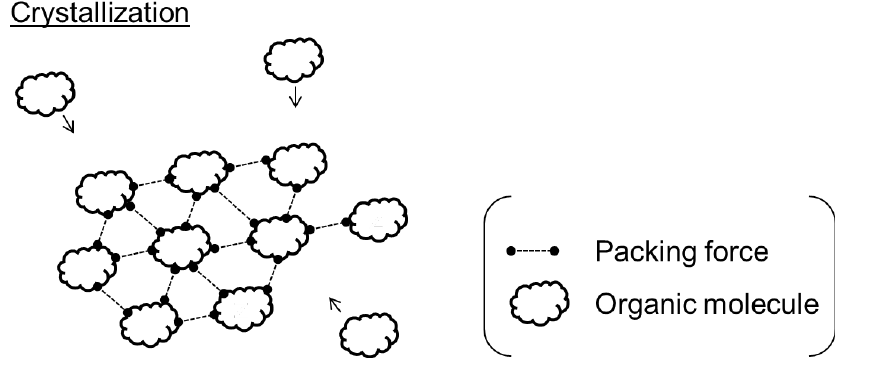
Figure 2. Intermolecular interactions for determining the packing of organic molecules during the crystal-growth